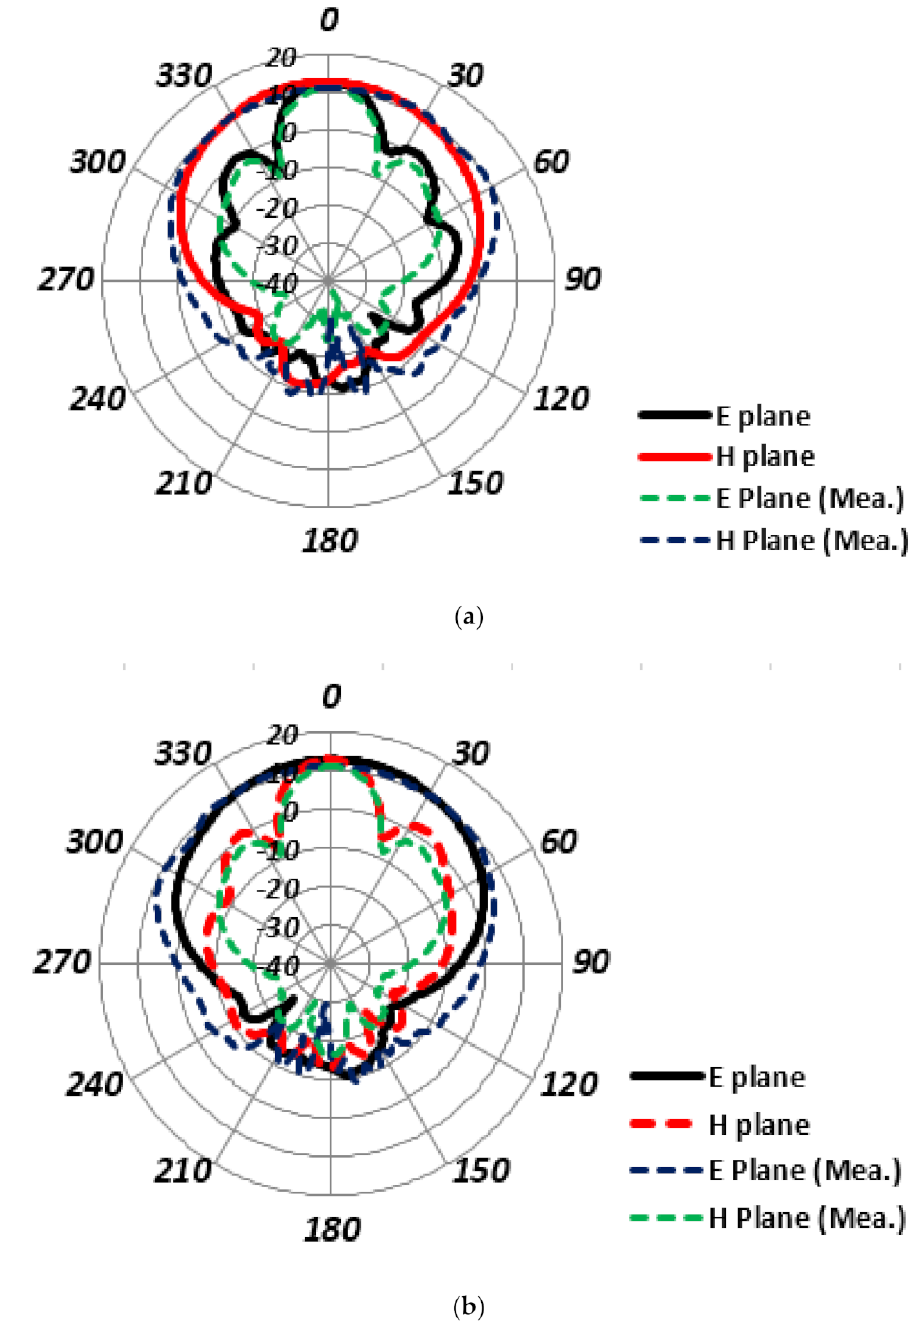
Figure 9. Corporate array MIMO configuration gain pattern for: ( a ) port-1, ( b )